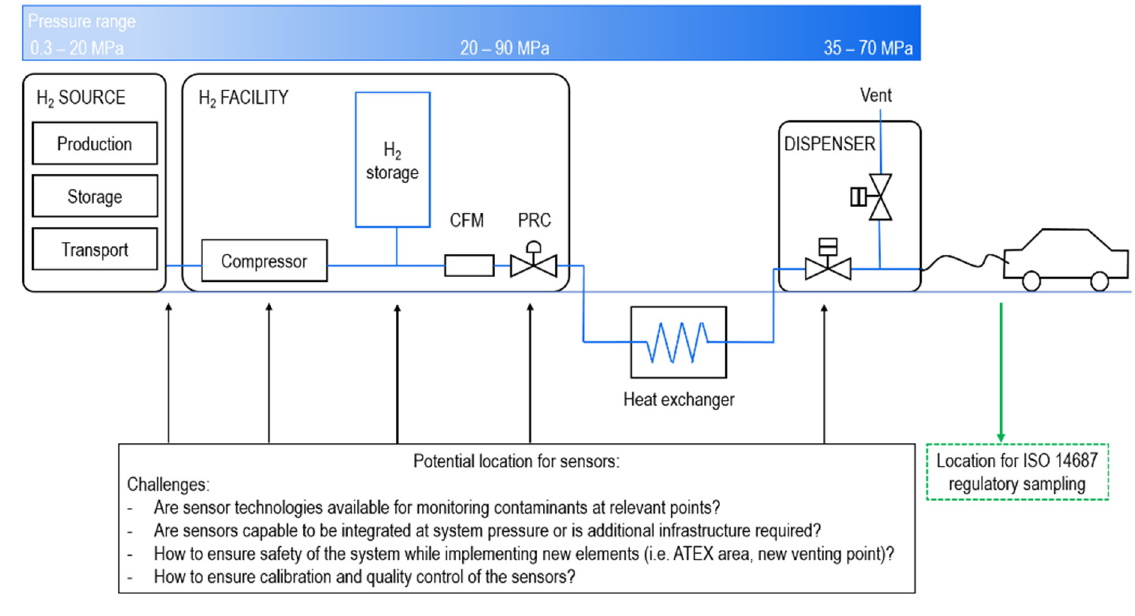
Figure 1. Scheme of a HRS station with potential locations for sensors and associated challenges.